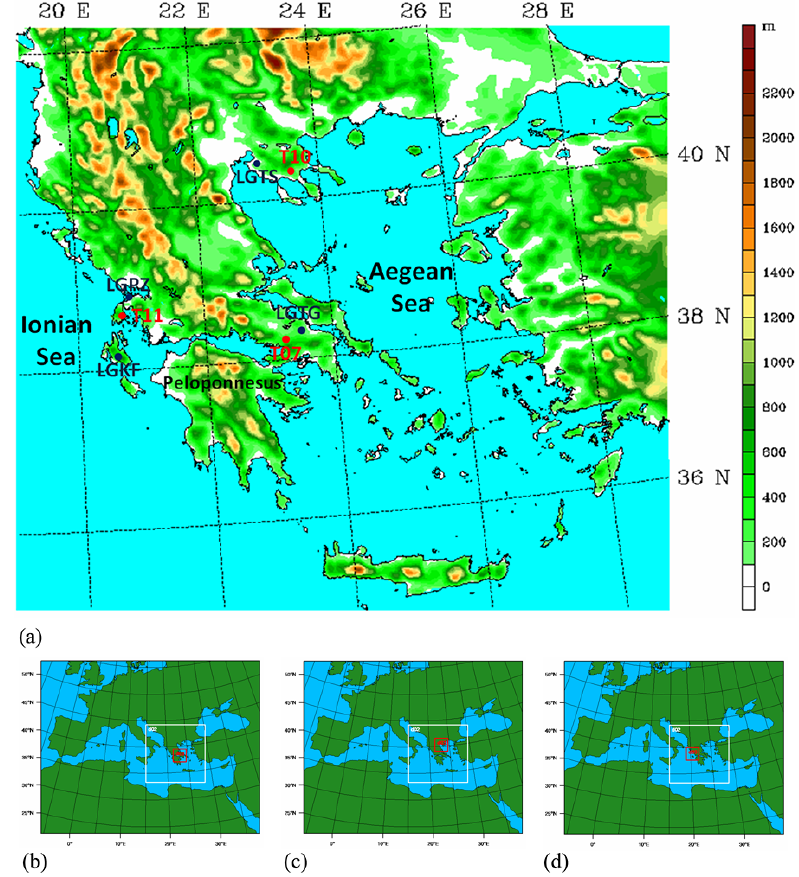
Figure 1. The upper image (a) illustrates the actual topography of Greece with the location (black dots) of tornadoes and meteorological stations (red and blue abbreviations, respectively). The three nested domains used for numerical investigations of tornado events (lower images) are illustrated during (b) 17 November 2007, (c) 12 February 2010 and (d) 20 September 2011. In (b) , (c) and (d) images D1 is the outer domain, D3 is the inner domain and D2 is the intermediate